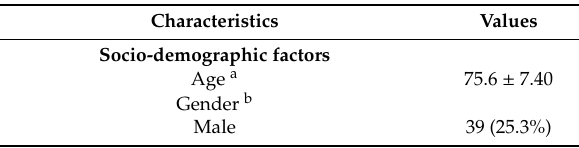
Table 1. Characteristics of the participants ( N =